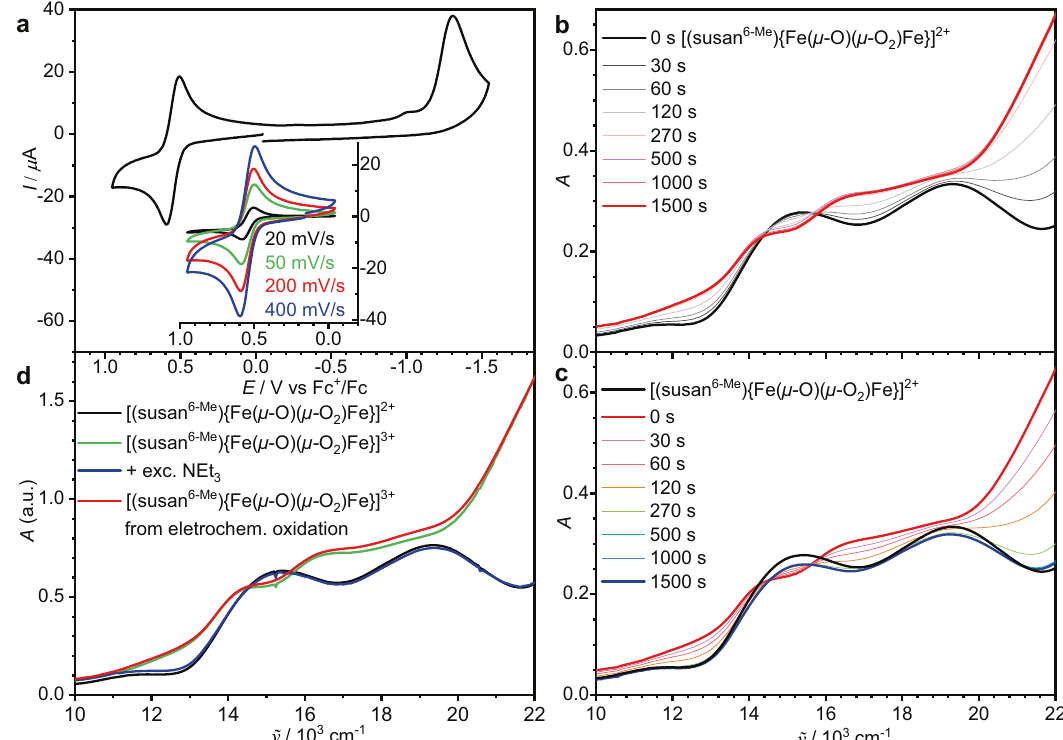
Fig. 4 Electrochemical/spectroelectrochemical characterization of [(susan 6-Me ){Fe III ( μ -O)( μ -O 2 )Fe III }](ClO 4 ) 2 and oxidation to [(susan 6-Me ){Fe IV ( μ - O)( μ -1,2-O 2 )Fe III }] 3 + . a Cyclic voltammograms of [(susan 6-Me ){Fe III ( μ -O)( μ -O 2 )Fe III }](ClO 4 ) 2 at − 20 °C in CH 3 CN solution (0.2 M (NBu 4 )PF 6 ) recorded at a GC working electrode. Scan rate 200 mV s − 1 unless noted otherwise. Spectroelectrochemical measurements at − 40 °C in CH 3 CN (0.2 mM with 0.1 M (NBu 4 )PF 6 ) during b oxidation at 0.68 V vs Fc + /Fc and c re-reduction at 0.16 V vs Fc + /Fc. d Chemical oxidation with one equivalent (thia)ClO 4 at − 60 °C in CH 3 CN/CH 2 Cl 2 (1:1) and re-reduction with excess NEt 3 . The chemically oxidized species (green) almost superimpose with the electrochemically oxidized species (red).